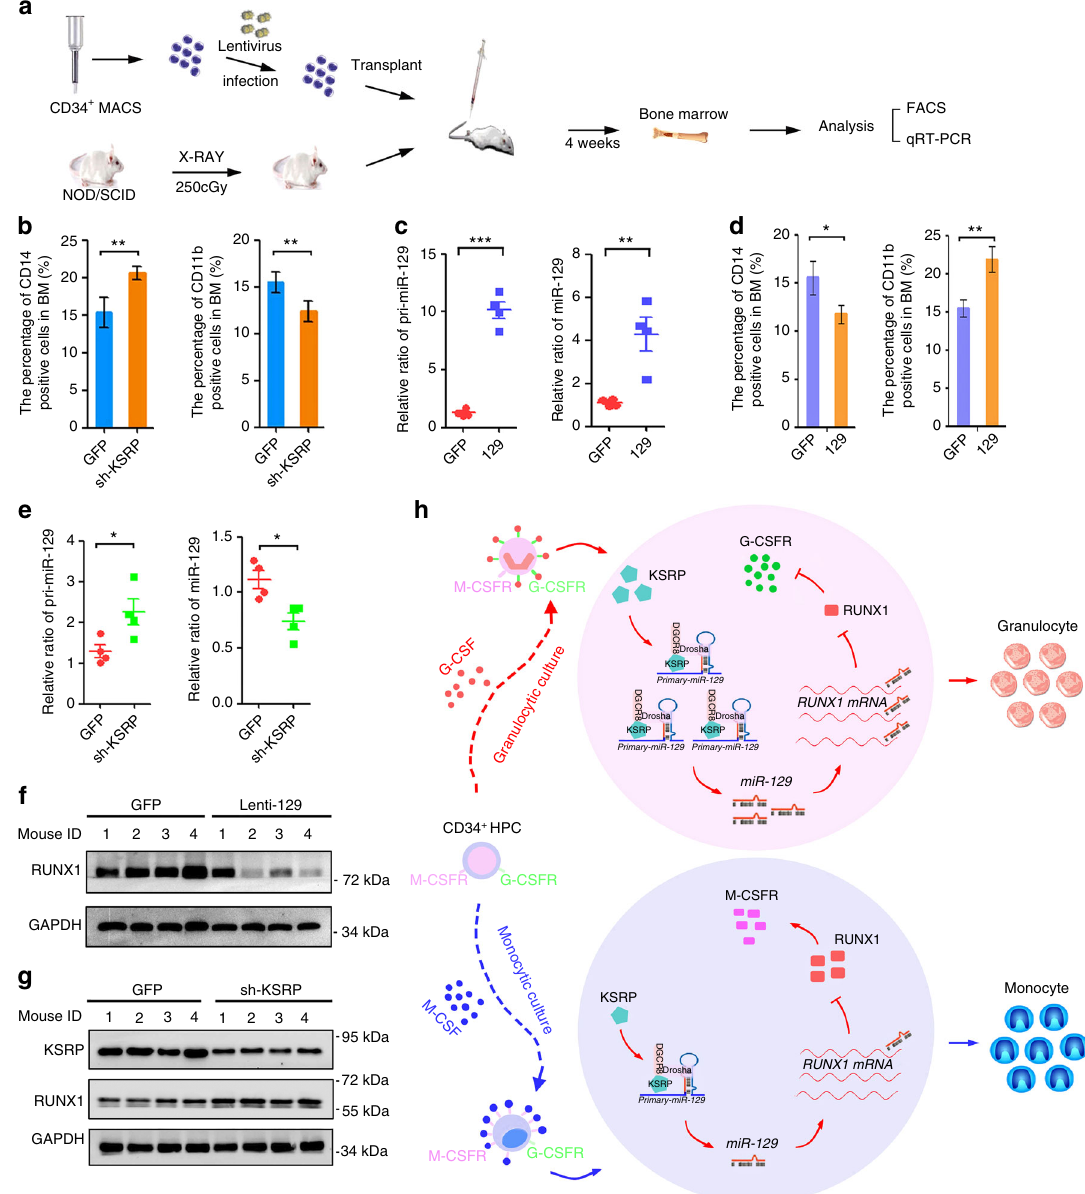
Fig. 10 KSRP and miR-129 regulate monocytic and granulocytic differentiation in vivo. a A schematic representation of the in vivo experimental design for the transplantation of CD34 + HPCs isolated from cord blood into mice ( n = 4). b The CD14 + and CD11b + populations in BM from mice transplanted with lenti-sh-KSRP or lenti-GFP-transduced HPCs were monitored by FACS. c qPCR analysis of pri-miR-129 and mature miR-129 expression in BM from mice transplanted with the lenti-GFP- or lenti-129-transduced HPCs. d The CD14 + and CD11b + populations in BM from mice transplanted with lenti-129- or lenti- GFP-transduced HPCs were monitored by FACS. The quantitation is shown in the left panel. e Schematic representation of a model describing the role of the KSRP-miR-129-RUNX1 axis in regulating the normal lineage-speci fi c differentiation of CD34 + HPCs. f qPCR analysis of pri-miR-129 and mature miR-129 expression in BM from mice transplanted with lenti-GFP- or lenti-sh-KSRP-transduced CD34 + HPCs. g Immunoblot of RUNX1 expression in BM from mice transplanted with lenti-129- or lenti-GFP-transduced HPCs. h Immunoblot of KSRP and RUNX1 expression in BM from mice transplanted with lenti-sh- KSRP- or lenti-GFP-transduced HPCs. Data are shown as means ± s.d. * P < 0.05, ** P < 0.01, *** P < 0.001, Student ’ s t